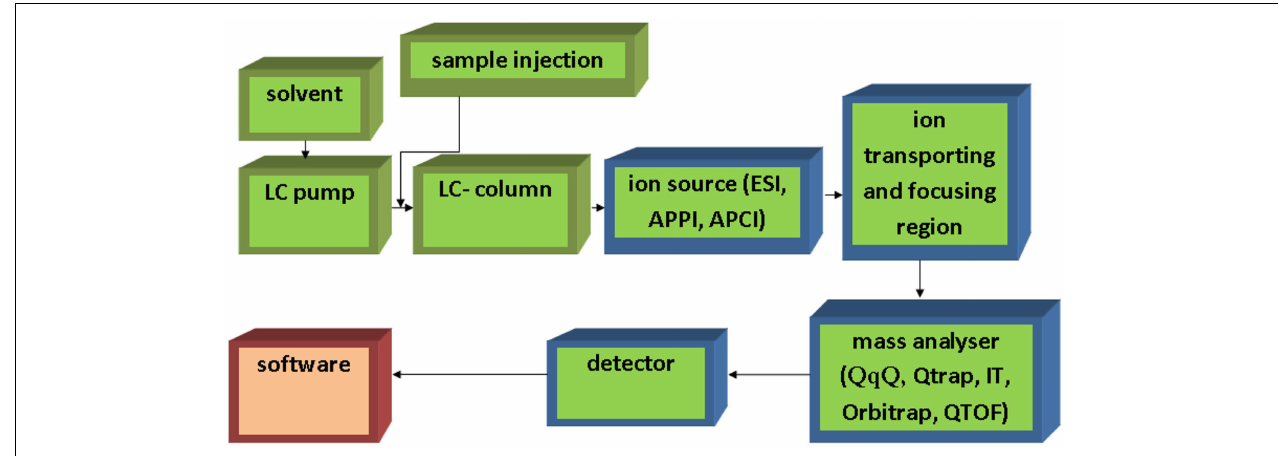
FIGURE 2 | Simple schematic of LC-MS